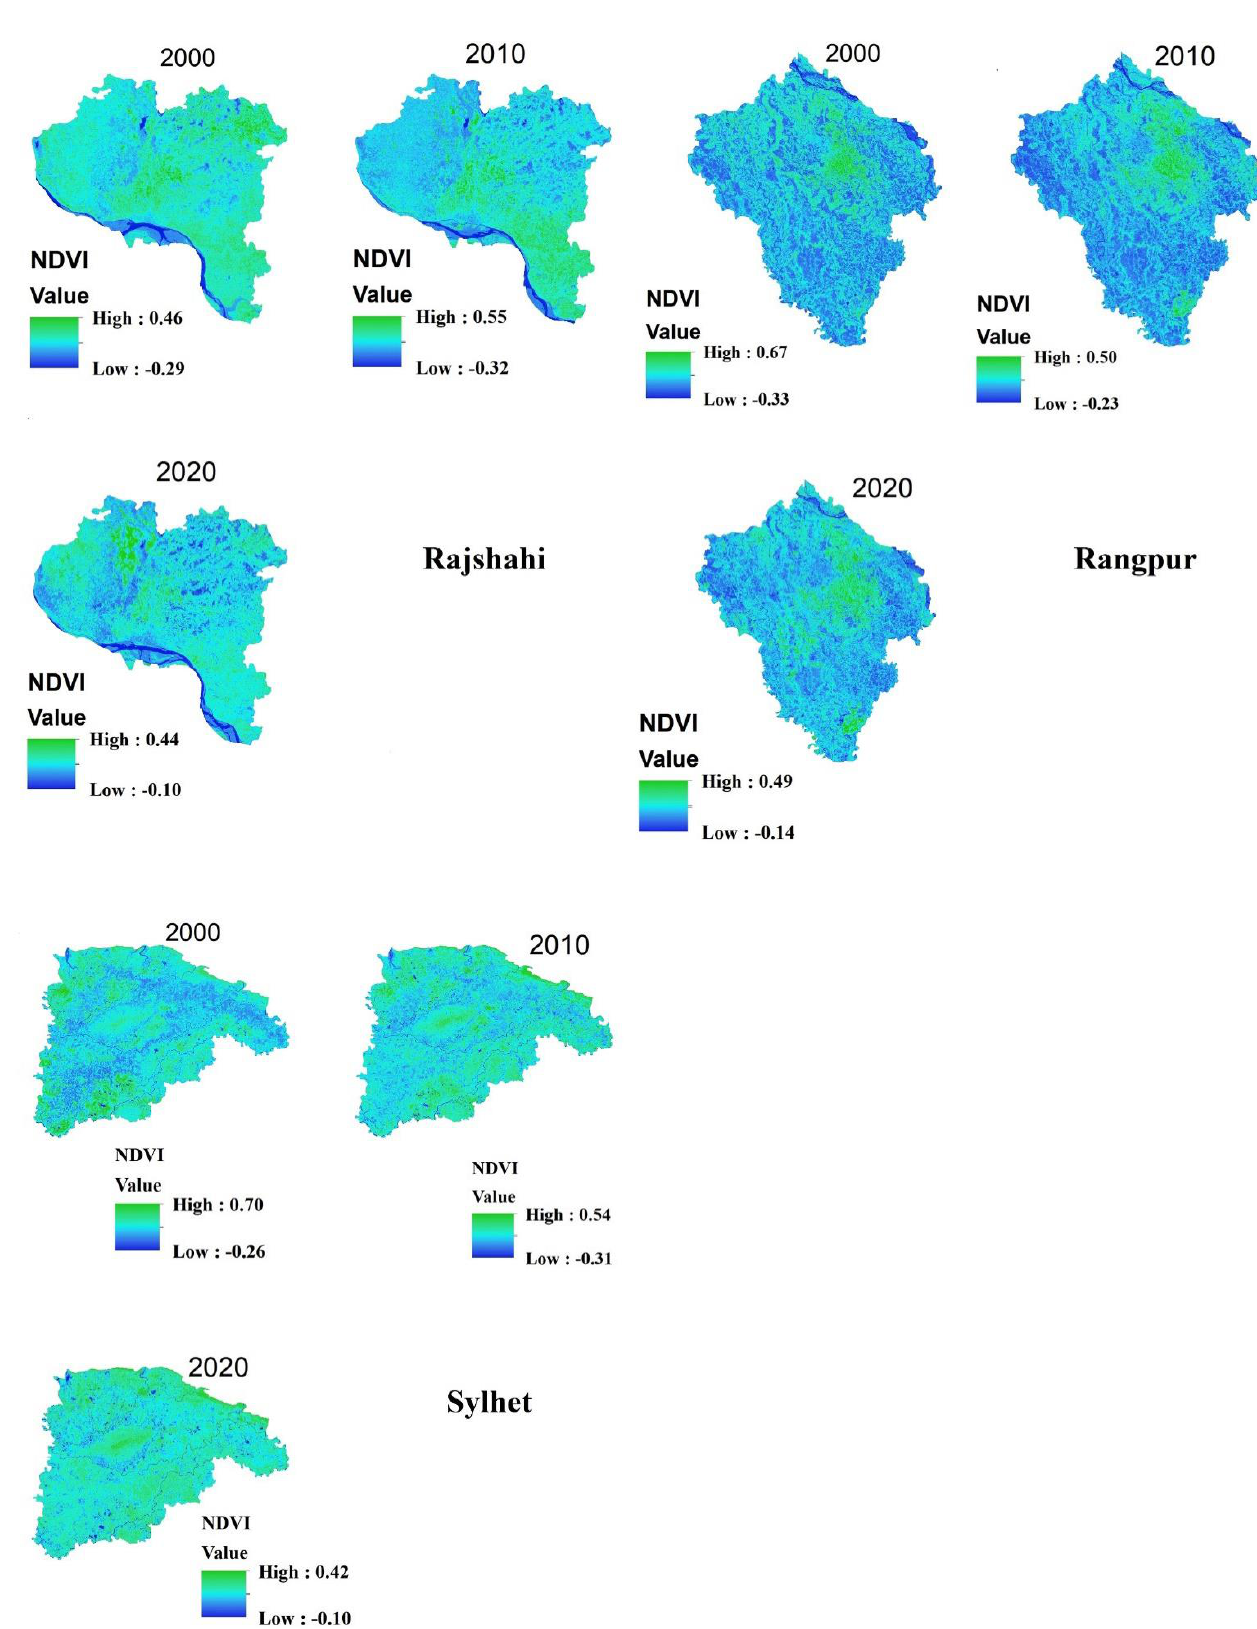
Figure 5. Spatiotemporal distributions of NDVI in seven districts of Bangladesh.